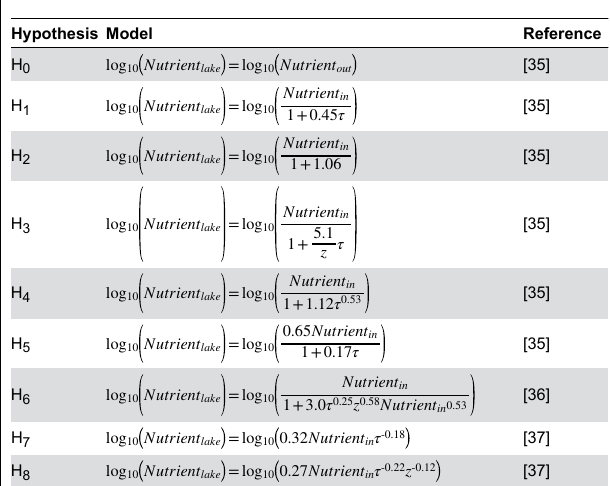
Table 1. Hypotheses tested.